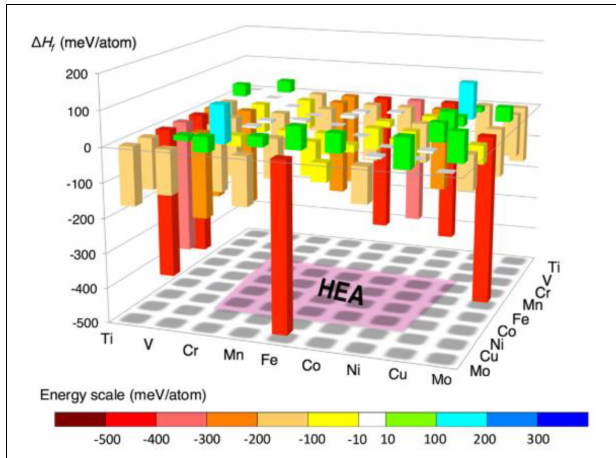
FIGURE 4 | Graphical representation of high-throughput first-principles simulation method (Curtarolo et al., 2005).